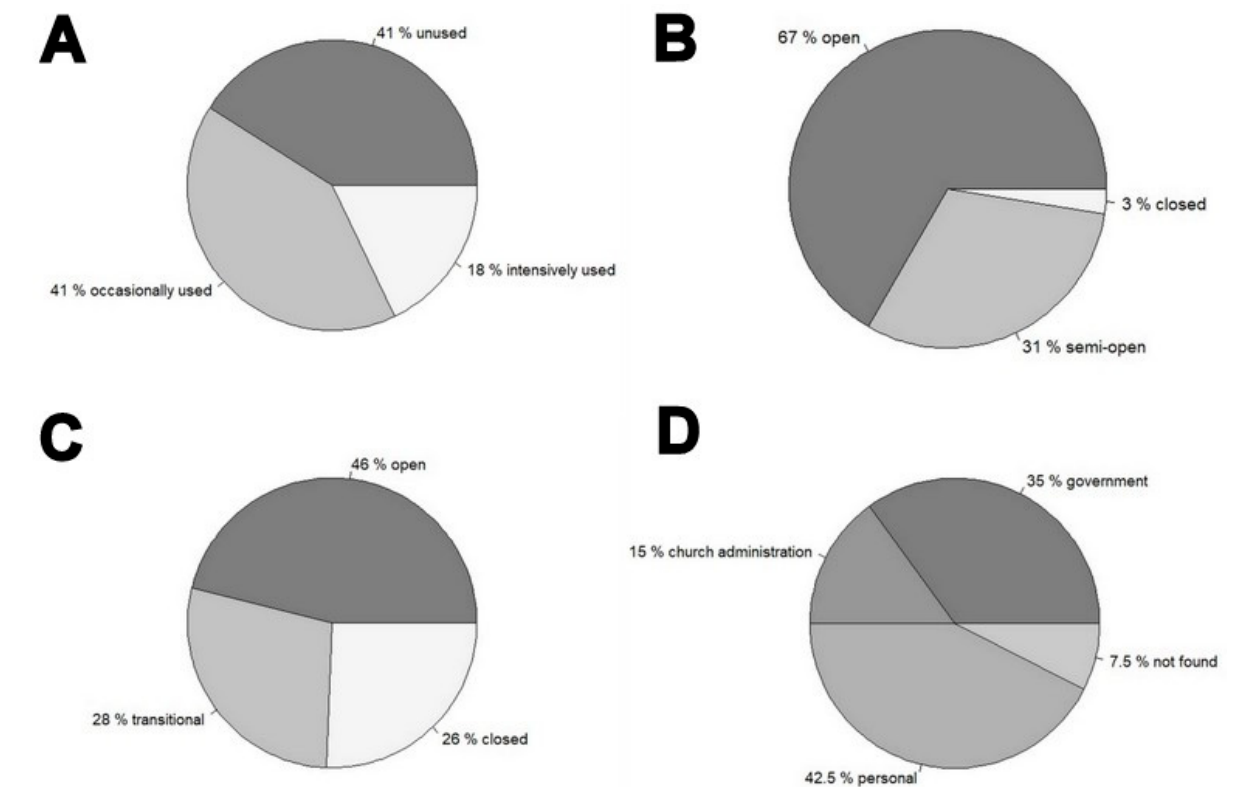
Figure 4. ( A )—Rate of human use of indoor environment in SA-CEFs ( n = 39); ( B )—Entrance accessibility in SA-CEFs ( n = 39); ( C )—Type of SA-CEF’s surrounding exterior environment ( n = 39); ( D )—Distribution of SA-CEF’s owners ( n = 39).